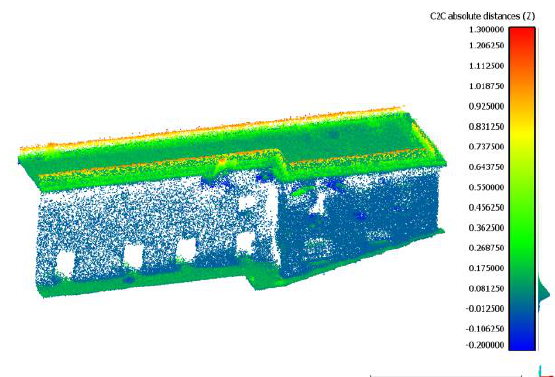
Figure 7 . Distances along the z-axis resulting from the Cloud- to-Cloud application, the registration of the two point clouds was not applied.